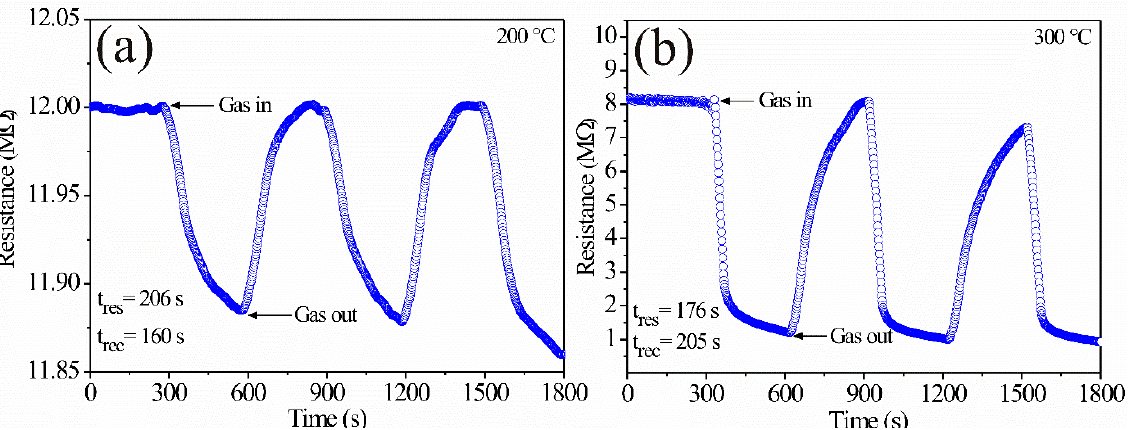
Sensors 2021 , 21 , x FOR PEER REVIEW 13 of 16 Figure 11. Dynamic response of ZnAl 2 O 4 pellets in an air–propane mixture at temperatures: ( a ) 200 °C, ( b ) 300 °C.